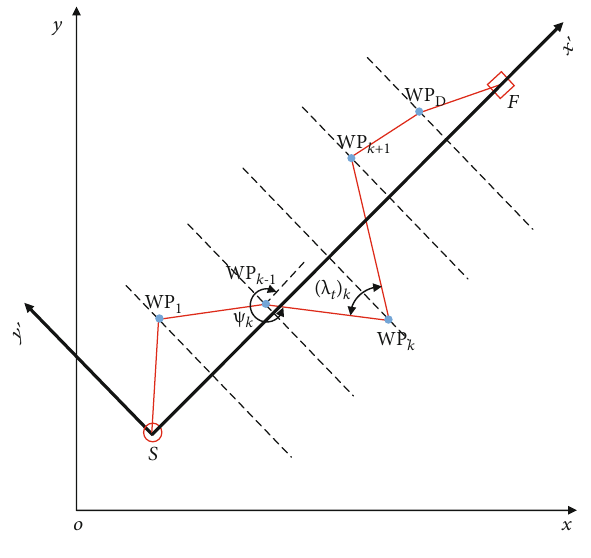
Figure 2: The coordinate